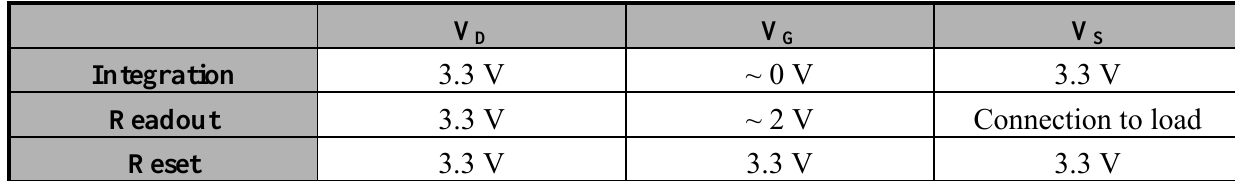
Table 1. Biasing conditions of the pixel